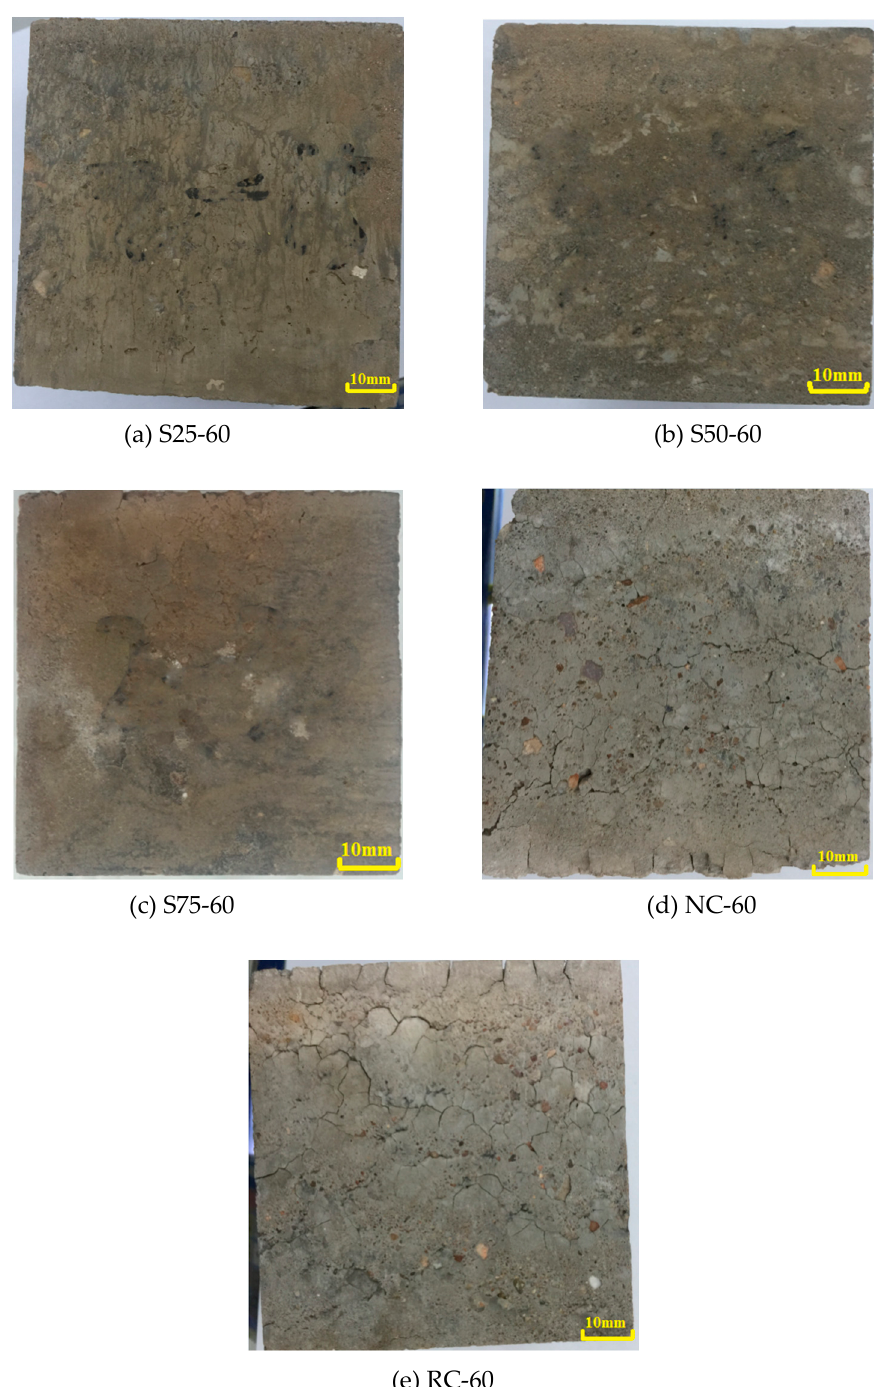
Figure 3. Appearance of specimens after 60 cycles of sulfate attack.